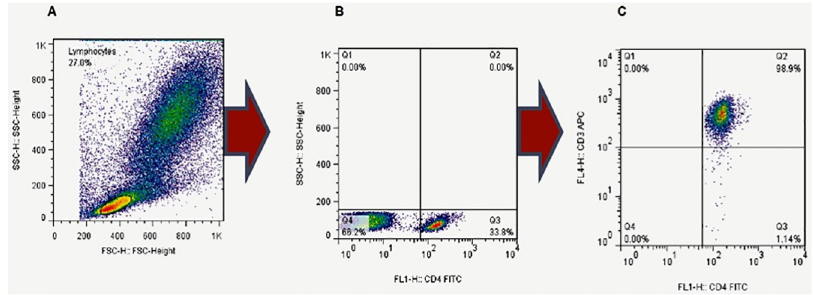
Fig 1. Characterization of CD4+ T-cell sub-populations. (A) Initial gating was performed on lymphocytes in the overallcell populationduringacquisition. (B) The CD4+ T-cell populationwas then selectedby gating on CD4+ cells in the lymphocyte cell populationduringanalyses. (C) Due to the limitation of the four-color cytometer, the populationsof CD4+ cells used in subsequent analyseswere CD4+ cells from the lymphocyte gate. To determinethe proportionof CD4+ cells that were T-cells (CD3+CD4+), expressionof CD3 by the CD4+ cells (gated in B) was determined. The medianproportionof CD3+CD4+(T-cells) amongthe